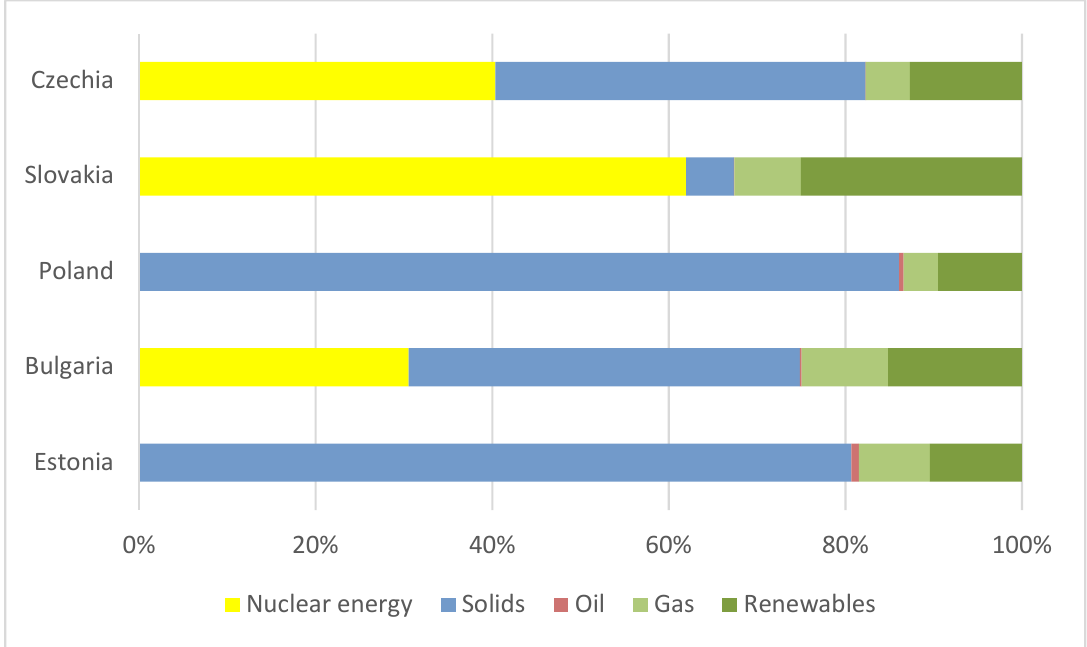
Figure 11. Structure of energy mixes for the sixth cluster . Source (own elaboration). The first cluster presents the production of energy from renewable sources at the highest level on an EU scale. In the energy mix, Finland has a slightly higher GHG emis- sions per capita than Sweden, as well as a higher energy intensity ratio, because the con- sumption of solid fuels constitutes 9%. Luxembourg comprises a single cluster. In comparison to other member states, it has the uppermost level of electricity consumption per capita. The GHG emissions per capita and the levels of energy dependence are also the highest. The third cluster (Figure 8) has a similar level of GHG emissions per capita, where all countries have reached levels below the EU average, which should be assessed posi- tively. The level of consumption of electric energy per capita is also below the EU average in all countries. There is a relatively low level of energy dependence, from 50% in Slovenia to 24% in Romania. The countries grouped in the fourth cluster (Figure 9) are characterized by a high level of energy dependence, from 52% for Croatia and 58% for Hungary to above 70% for